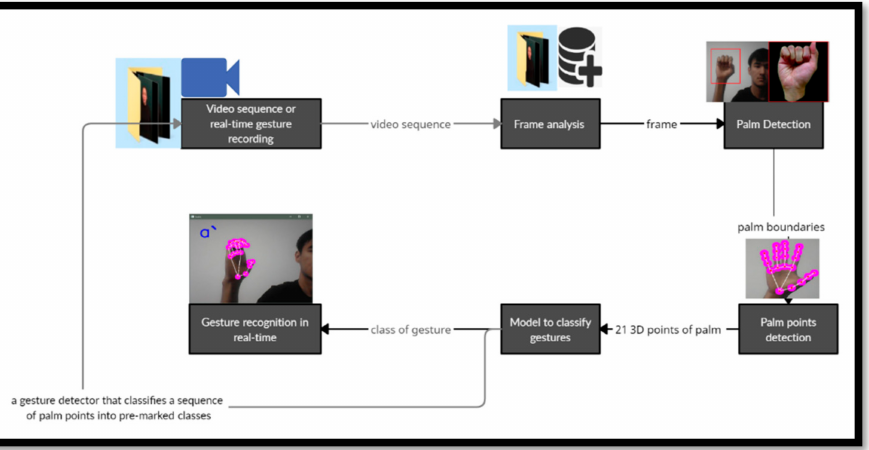
Figure 7. Sign language recognition in a real-time system based on the palm definition model.